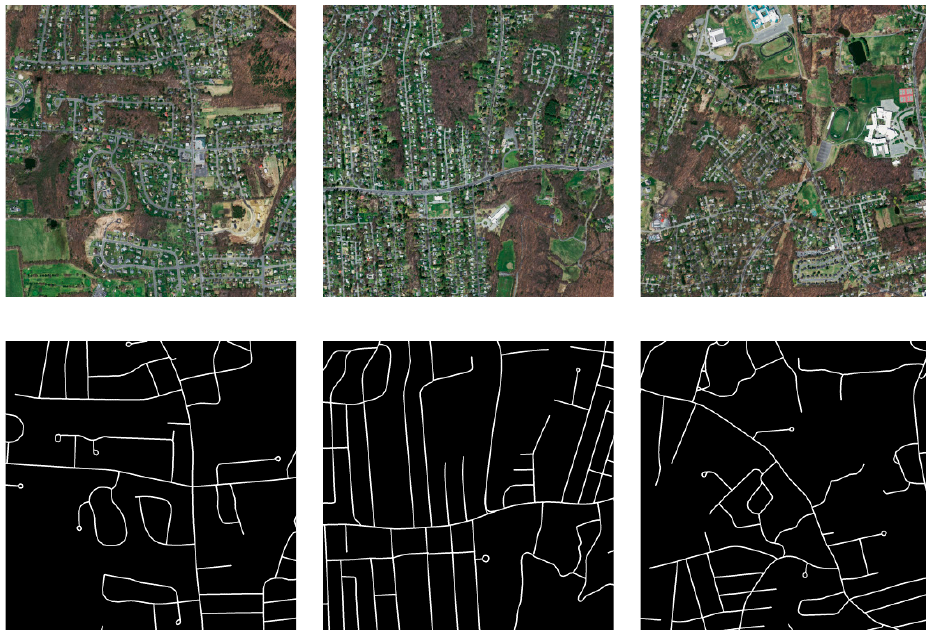
Figure 5. Sample images and labels of the Massachusetts Figure 5 Sample images and labels of the Massachusetts dataset.